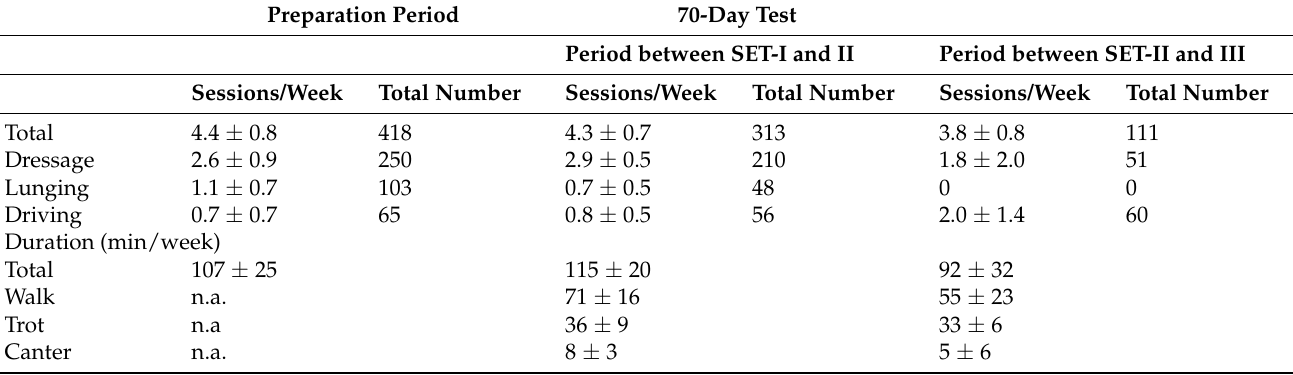
Table 2. External workload (duration and number of training sessions) per type, gait, and per week in young Friesian stallions during the preparation period ( n = 6 weeks) and 70-day studbook approval test); n.a. = not